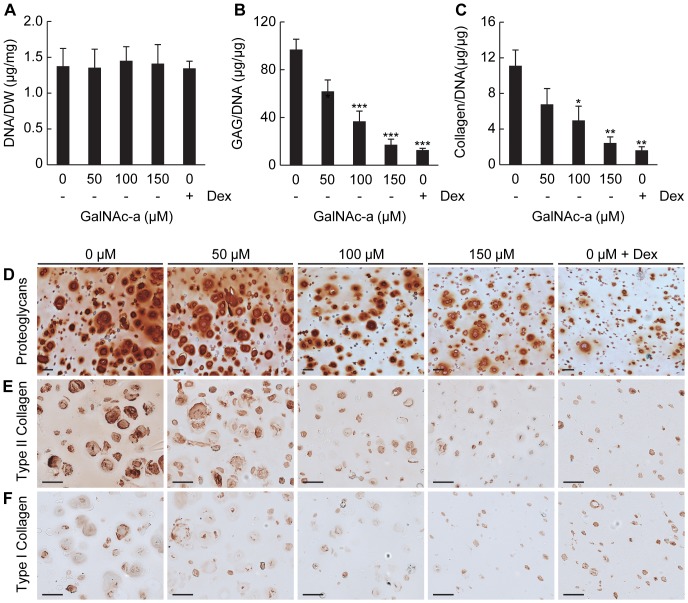
Biochemical analysis of MSCs undergoing chondrogenesis in the presence of ascorbic acid and GalNAc-a or dexamethasone in 3D hydrogels.Quantification of biochemical composition of (A) DNA normalized to construct dry weight, (B) sGAG normalized to DNA content and (C) total collagen normalized to DNA content (n = 4, * P<0.05, ** P<0.01, * P<0.001 versus no analog exposure). (D) Histological staining for proteoglycans using Safranin-O and (E,F) immunohistochemical staining for (E) type II collagen and (F) type I collagen (scale bar: 50 µm).